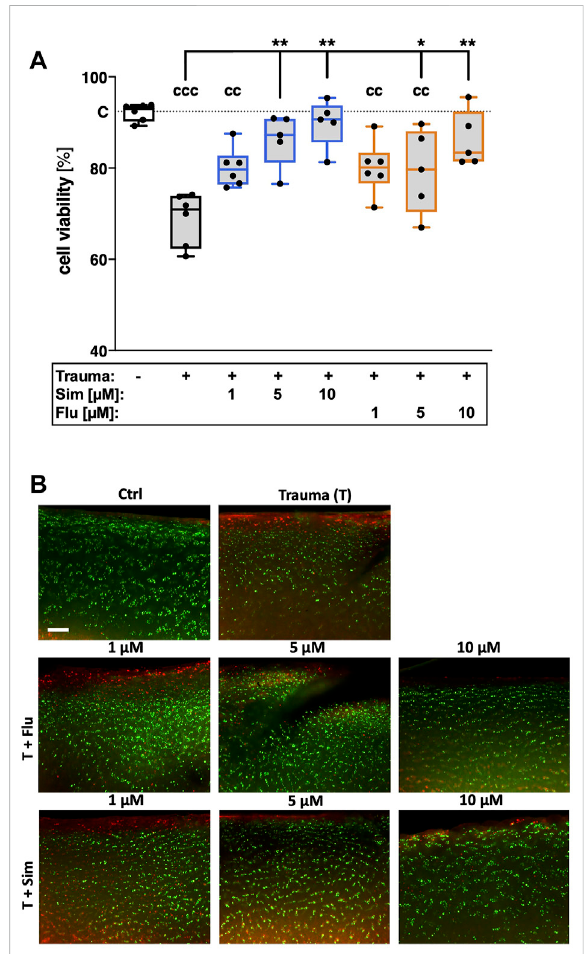
FIGURE 1 Effects of statins on cell viability after cartilage trauma. Cartilage explants were traumatized and treated with simvastatin (Sim) or fl uvastatin (Flu) at different concentrations (1 μ M, 5